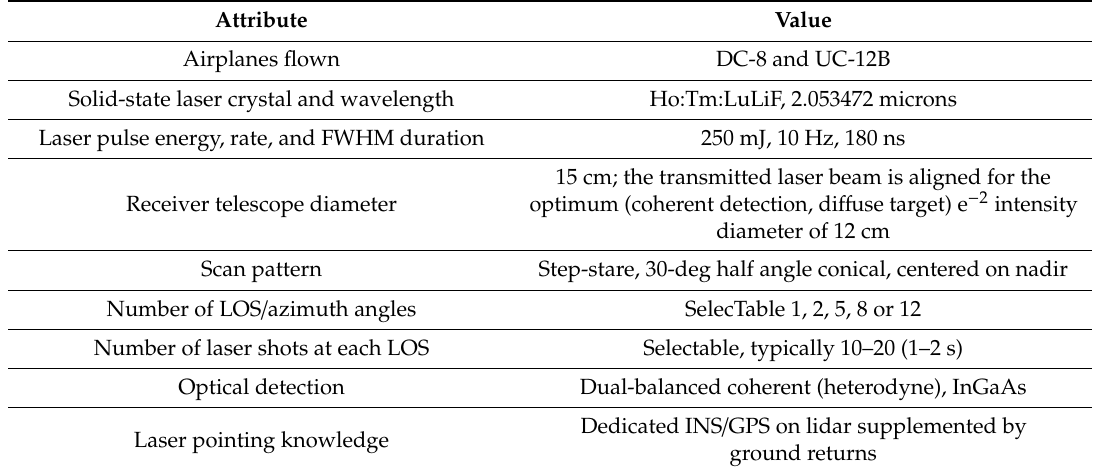
Figure 2. The DAWN instrument on board the NASA DC-8 during the 2017 CPEX. Table 2. DAWN Lidar